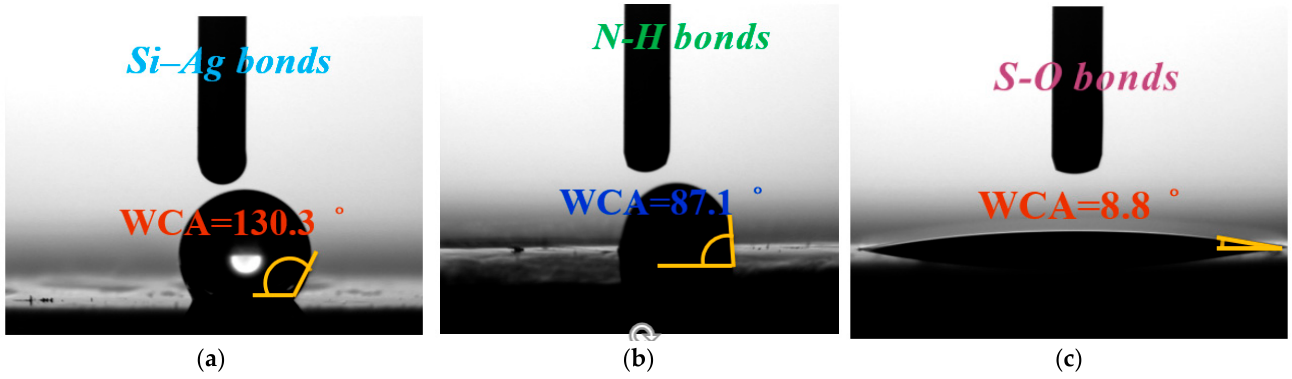
Figure 7. WCA observations of the Ag–SiNW arrays ( a ) before the immobilization process (WCA = 130.3°), ( b ) after the immobilization of BSA (WCA = 87.1°), and ( c ) after the immobilization of ZnSO 4 (WCA = 8.8°), using a CCD.